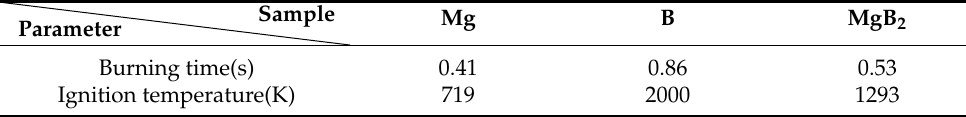
Table 2. Characteristic ignition parameters of Mg, B, and MgB 2